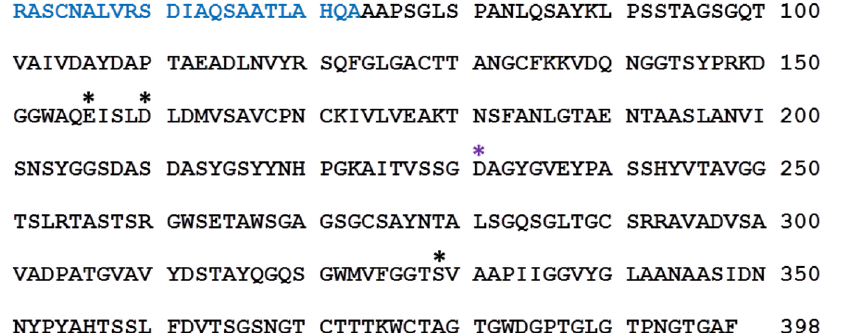
Figure 2. Aminoacid sequence of E40. Sequence labeled with aminoacid numbering from the N-terminus of the whole protein. 1–27 (red): putative signal peptide sequence (according to signalP 4.1 server prediction), 28–73 (blue): putative pro-enzyme sequence, 74–398 (black): mature form. Aminoacids partecipating to the active site are indicated by asterisks; in black, the putative catalytic triad.